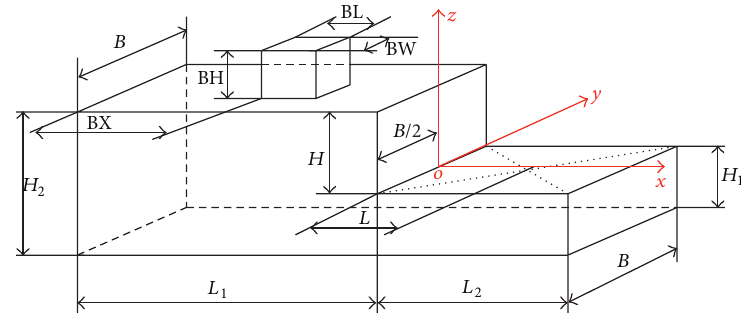
Figure 3: Simple frigate shape (SFS) dimensions.